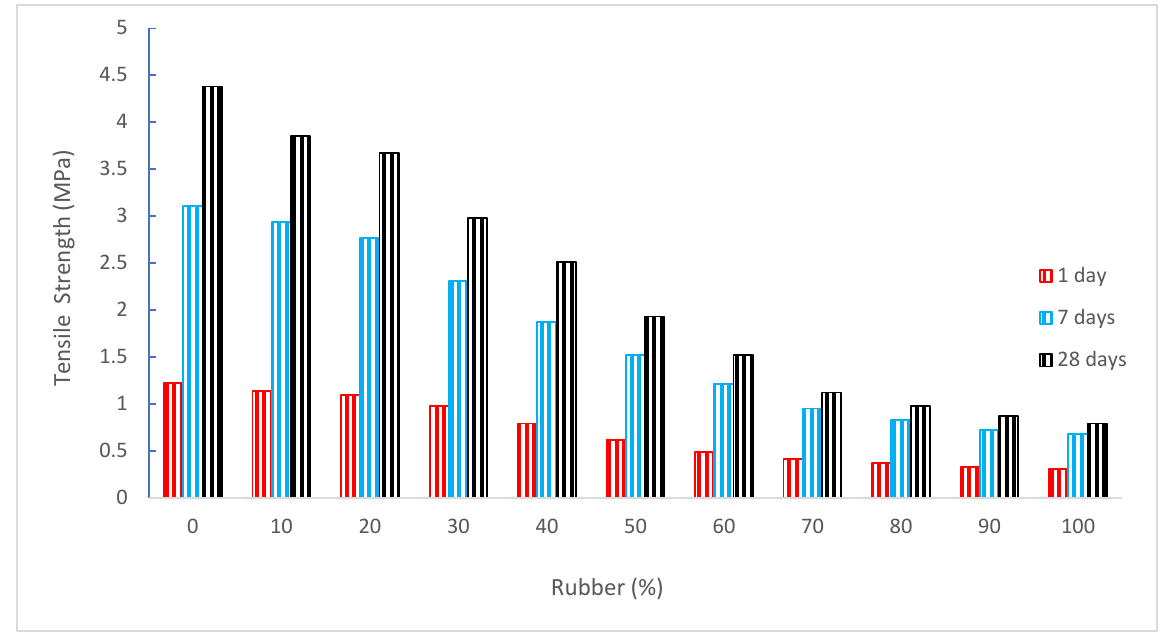
Figure 10. Tensile strength: data source [30]. Concrete’s compressive strength (CS) is decreased by 10% to 23% when rubber particles are substituted for 7.5% and 10% of the typical concrete’s aggregate. When rubber is substituted by 7.5% to 10%, the tensile strength (TS) of concrete decreases by 30% to 60% [64], which indicate that TS is more adversely affected as compared to CS. Concrete with a 10% replacement of shredded rubber shows a significant drop in TS of up to 76.59%, while concrete with a 5% replacement of shredded rubber shows a reduction of 55.42%. When 1% of shredded tire rubber was added to the overall aggregate composition, a small decrease of 7.62% was seen [70]. Research showed that when the rubber % rose, the values of splitting TS and FS dropped. To obtain results equivalent to the control concrete speci- mens, the research advised not exceeding a 10% rubber replacement [44]. In the case of rubber, concrete ’ s splitting tensile strength diminishes as the rubber level rises. Tensile strength (TS) values for 10% recycled concrete aggregate (RCA) are 3.16 MPa, 2.82 MPa, and 2.79 MPa for 0%, 5%, and 10% replacement levels of CR, respectively, when the fiber content is 1%. Studies have shown that adding fibers to concrete mixtures improves